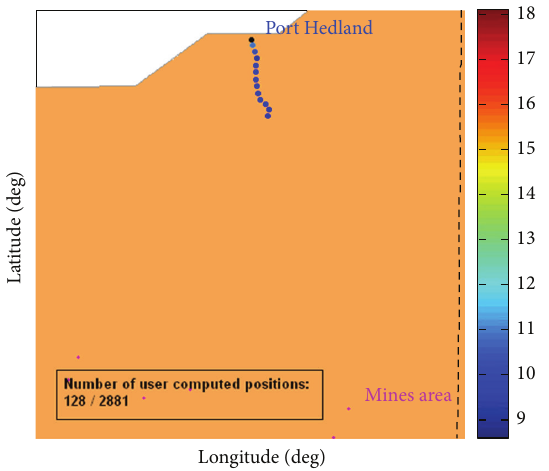
Figure 24: Horizontal accuracy mapping (“zoomed” view) − 24/24 GPS constellation and 6RF interfering satellites.